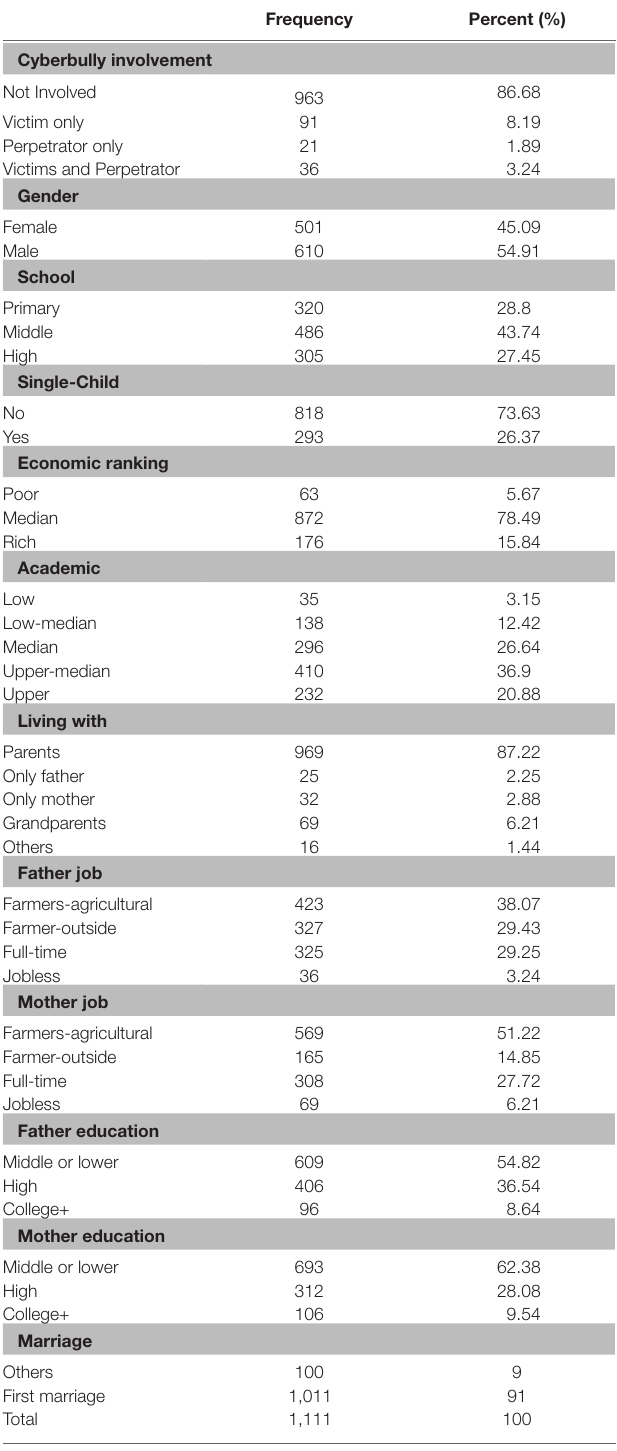
TABLE 2 | Characteristics of the